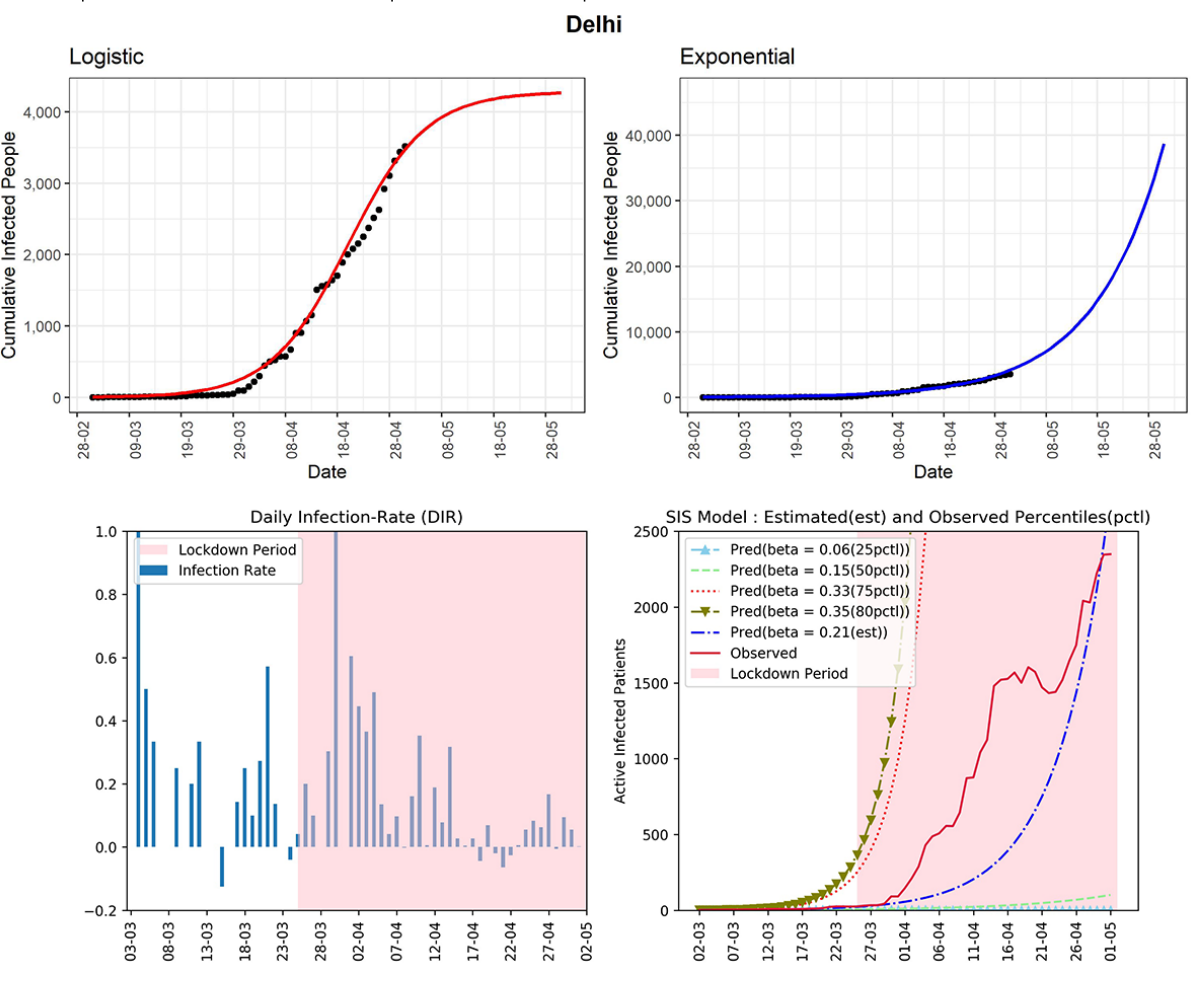
Figure 5. Graphs for the state of Delhi. SIS: